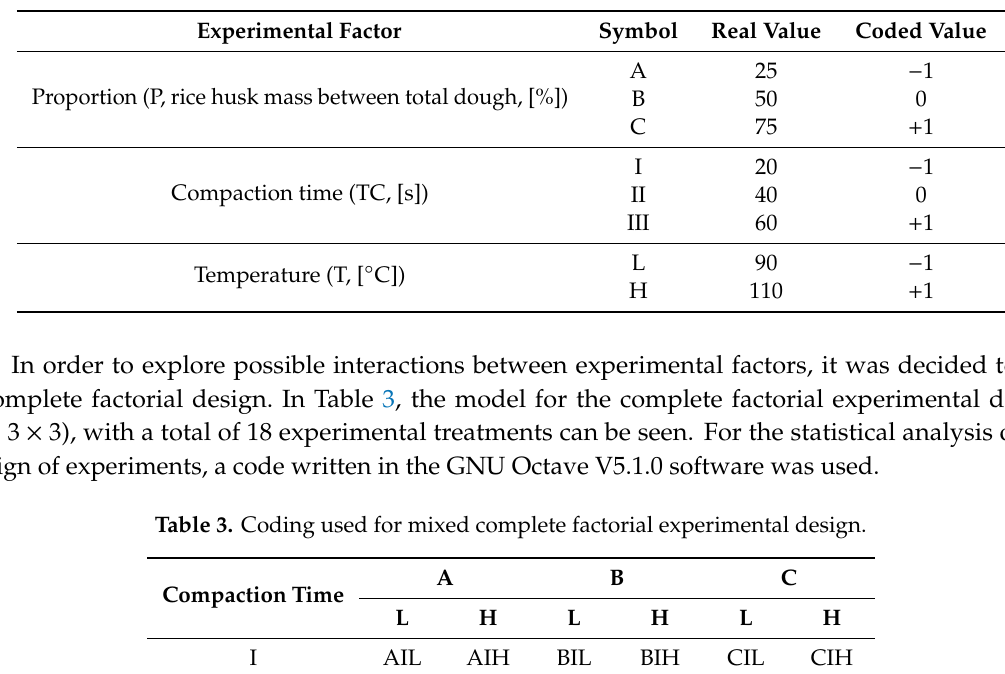
Table 2. Coding of experimental design treatments.